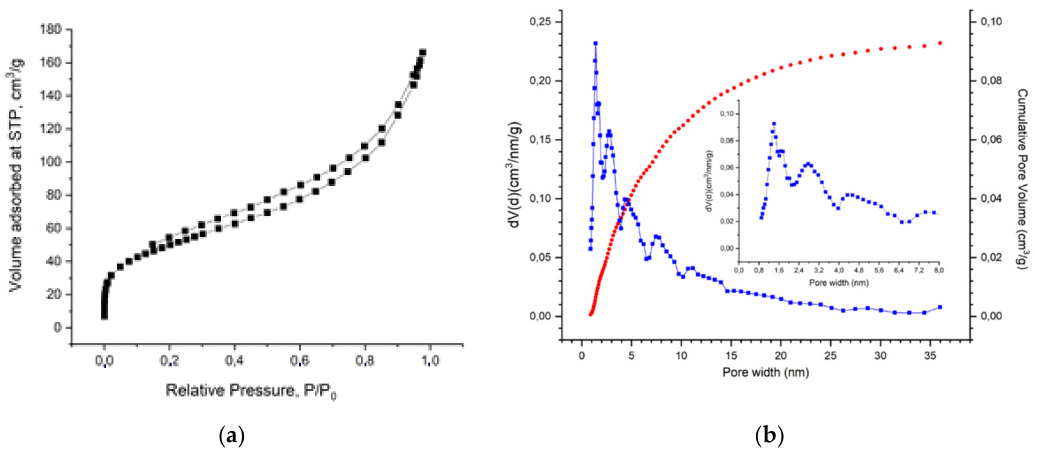
Figure 4. Pore space parameters of the r-GO/o-CNTs/PANI nanocomposite cryogel: ( a ) nitrogen adsorption-desorption isotherms, ( b ) pore size distribution obtained from DFT calculations assuming spherical/cylindrical pores (QSDFT